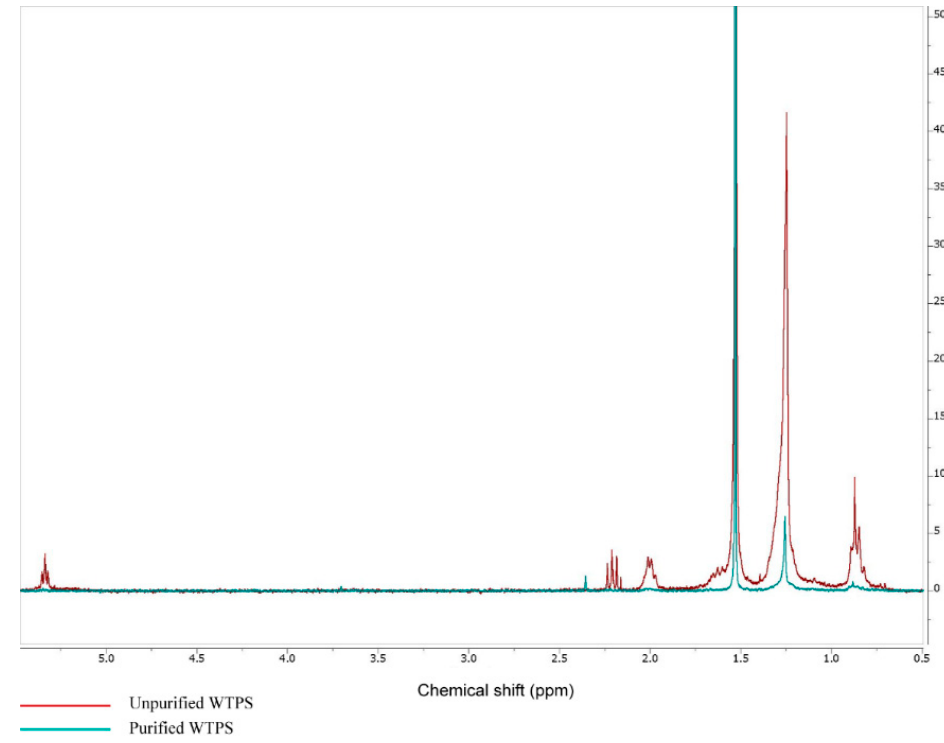
Figure 4. 1 H ‐ NMR spectra of unpurified and purified WTPS. Figure 4. 1 H-NMR spectra of unpurified and purified